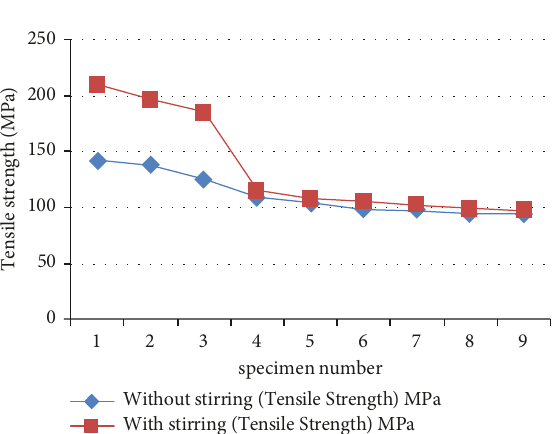
Figure 26: Graph for impact strength for different specimens.